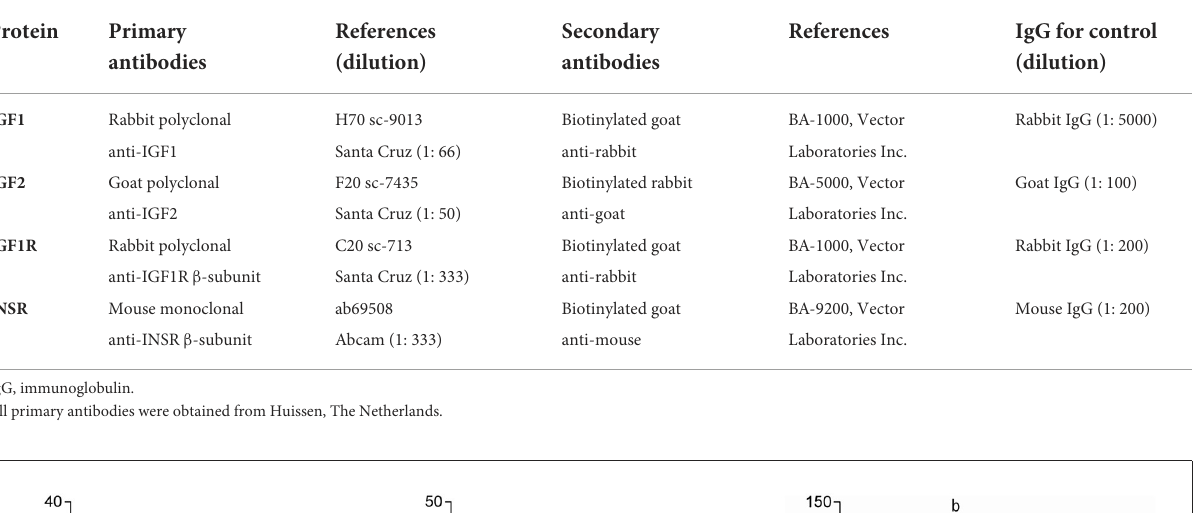
TABLE 2 List of antibodies and IgGs used for immunohistochemistry of equine endometrium and conceptus membranes.